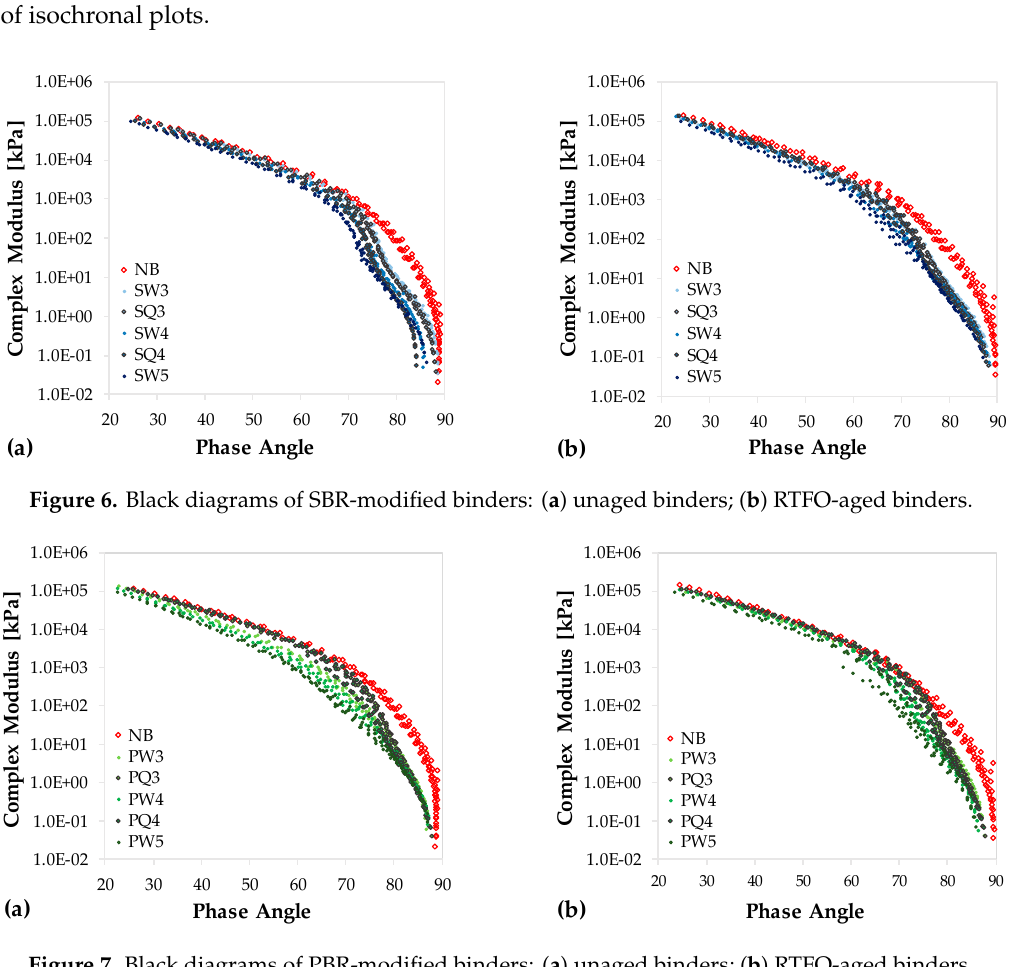
Figure 7. Black diagrams of PBR-modified binders: ( a ) unaged binders; ( b ) RTFO-aged binders.